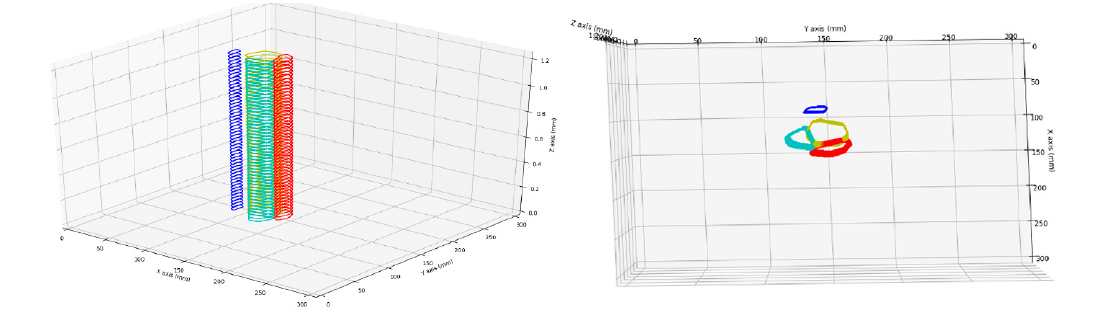
Figure 10. Example of 3D representation of the segmented prostate